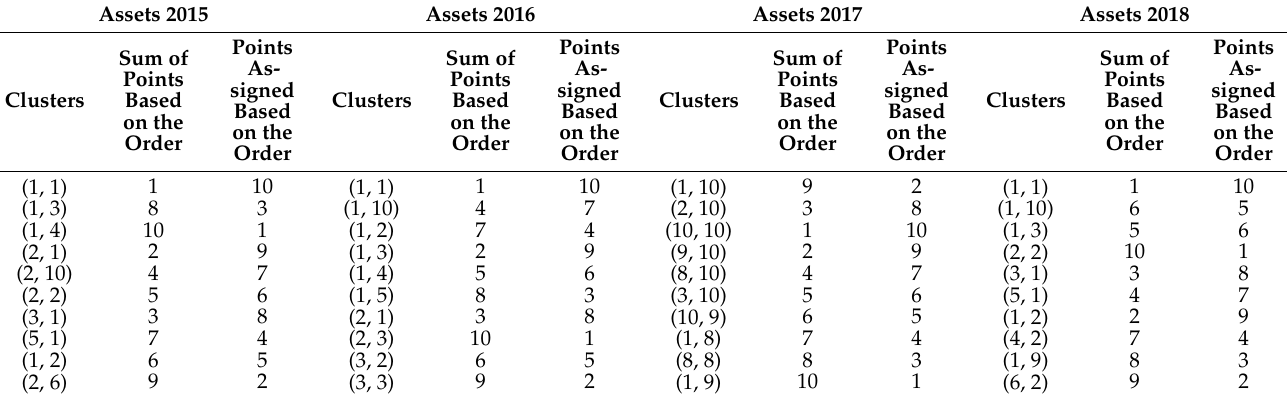
Table 25. Evaluation of clusters based on their order—Assets in 2015–2018.